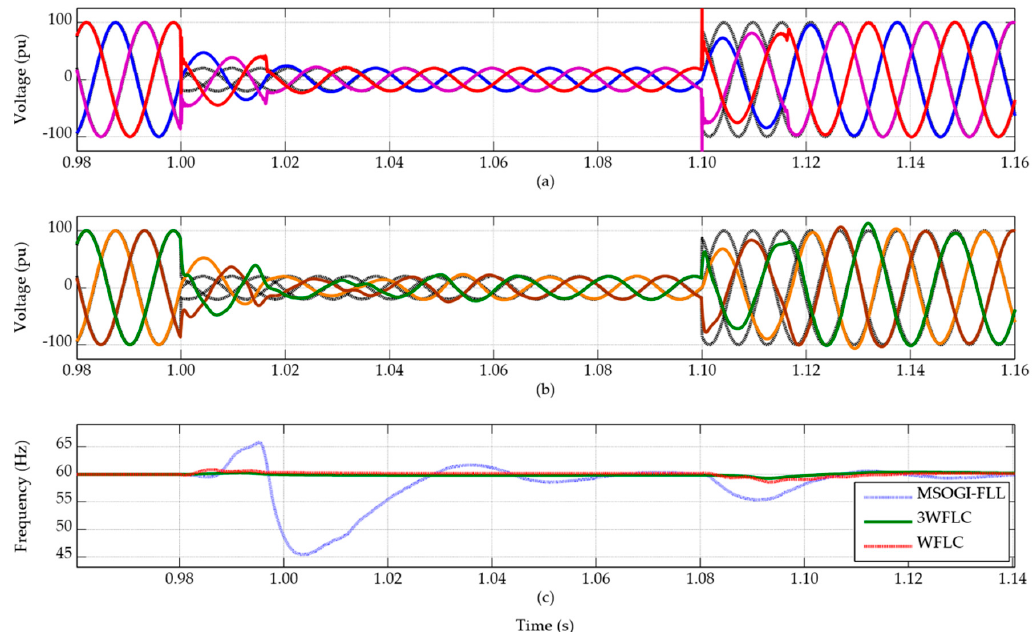
Figure 3. Results from simulation scenario 1, symmetrical voltage drop. ( a ) Sequence Detector Fourier Linear Combiner (SDFLC)voltage outline in voltage drop; ( b ) multiple second-order generalized integrators and frequency-locked loop (MSOGI-FLL) voltage outline in voltage drop; ( c ) Frequency transients during asymmetrical voltage drop.